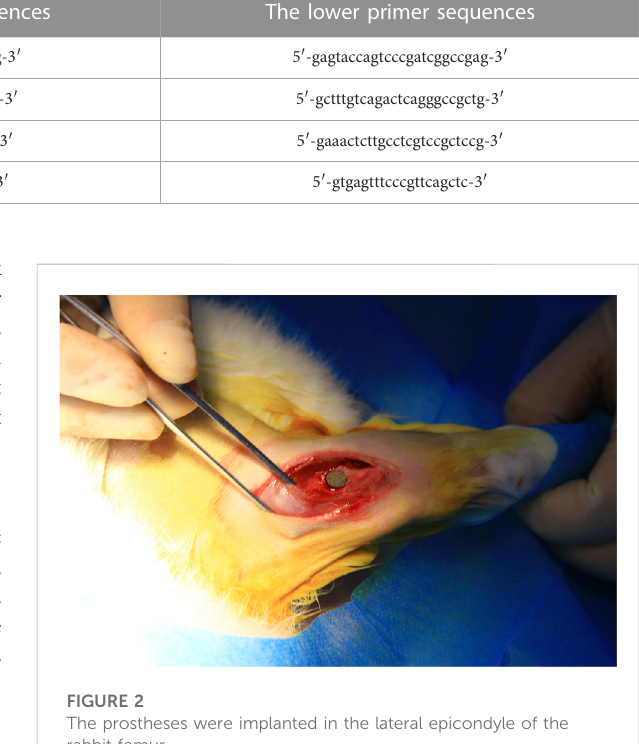
FIGURE 2 The prostheses were implanted in the lateral epicondyle of the rabbit